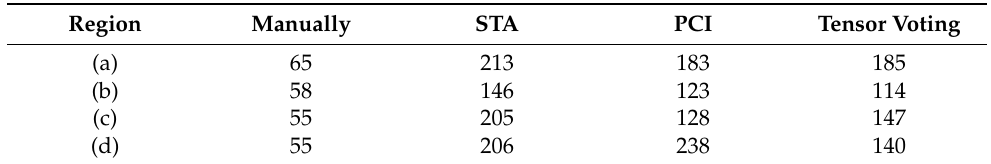
Table 1. The total number of lineaments in the four subareas of the Qianhe Graben. STA, segment tracing